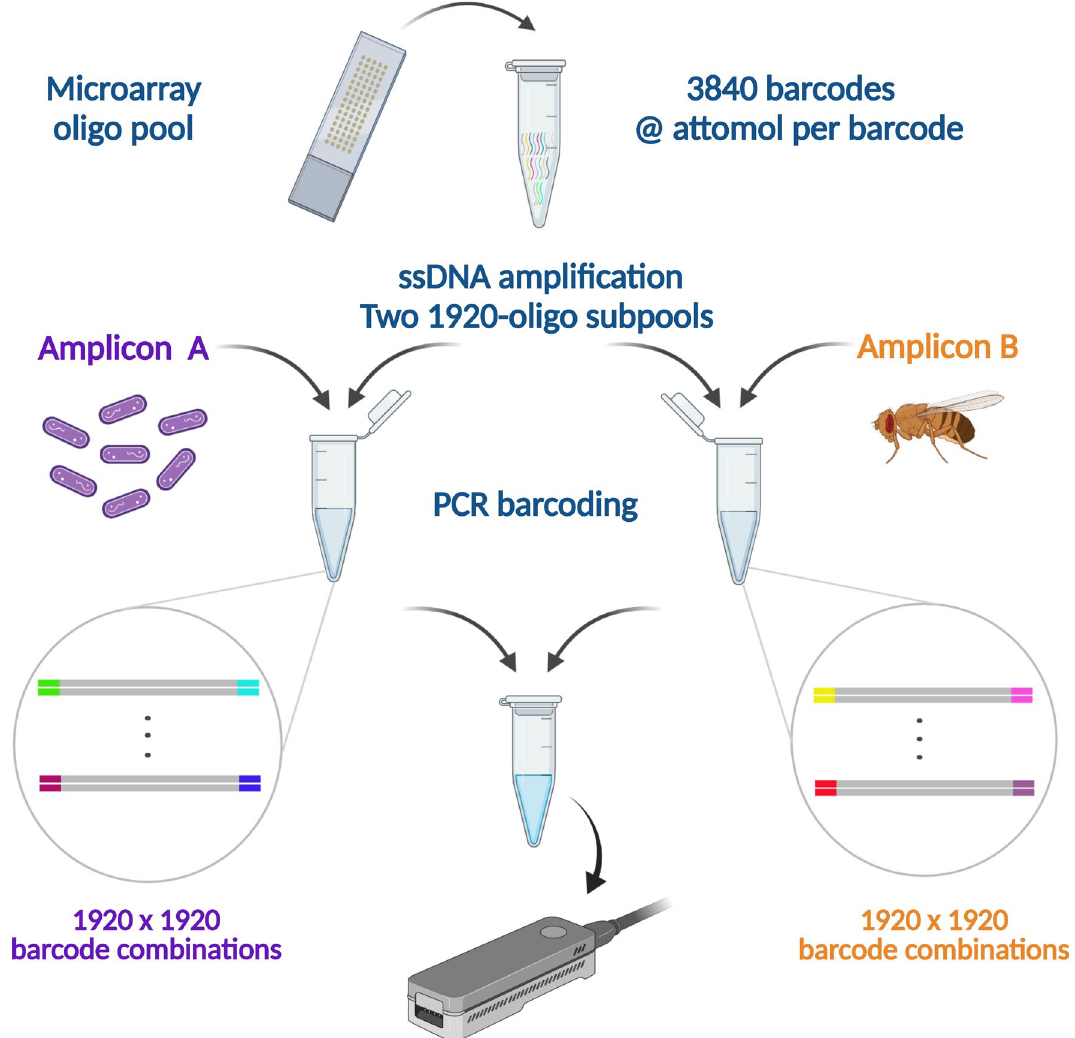
Figure 2. A barnyard experiment (two species) is used to assess the feasibility and performance of NS-watermark barcoding for massively parallel sequencing. A subset of 3840 NS-watermark barcodes, from a set of 4096, is synthesized in a microarray and cleaved to form an oligo pool, which is further divided into two subpools of 1920 barcodes each, followed by preferential amplification of one strand. The resulting ssDNA-enriched subpools are used to tag B. Pertussis (sample A) and D. mojavensis (sample B) amplicons. Barcoded amplicon subpools A and B are pooled in a molar ratio of 1:2 and sequenced together on the